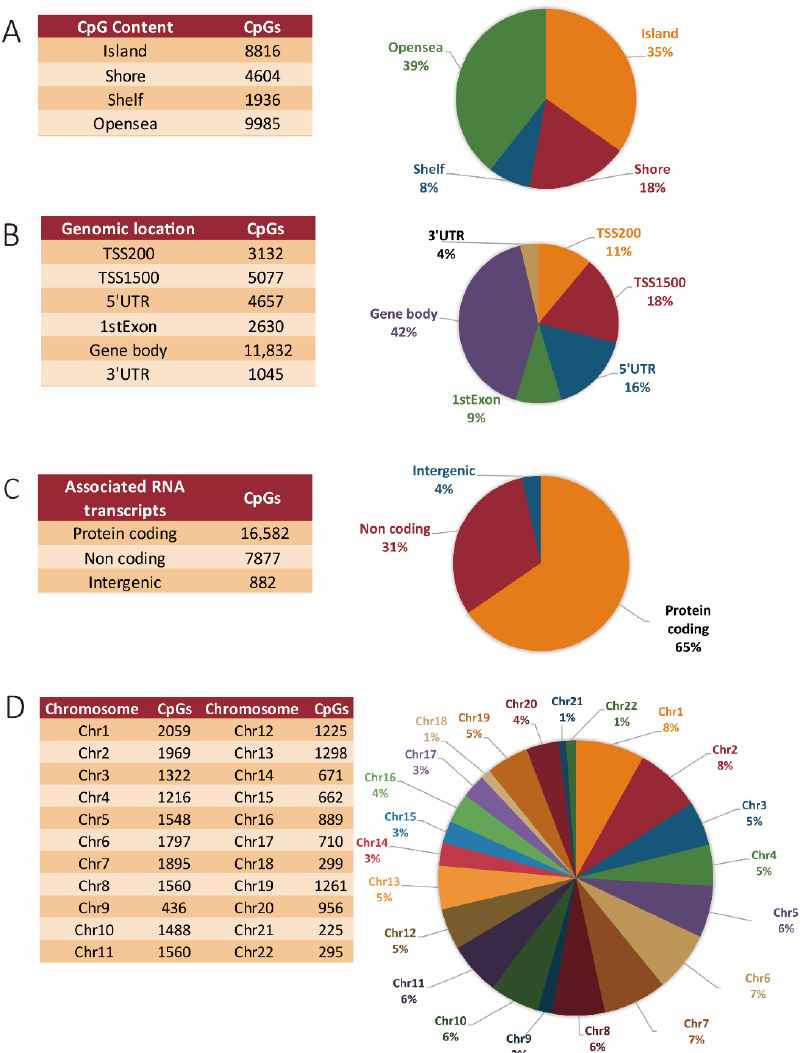
Figure 1. DNA methylation landscape in CRC tissues. ( A ) Genomic distribution of CpG sites in relation to CpG islands and neighboring shores, shelves, and open seas. ( B ) Functional genomic and neighborhood location and distribution of methylated CpG sites. ( C ) Distribution of CpGs in relation to coding, non-coding, and intergenic regions, respectively. ( D ) Chromosome distribution of the differential methylated sites. Table 1. Overview of genome-wide methylation burden across all chromosomes. The number of hypermethylation and hypomethylation events in relation to CpG islands and neighborhood re- gions are given.